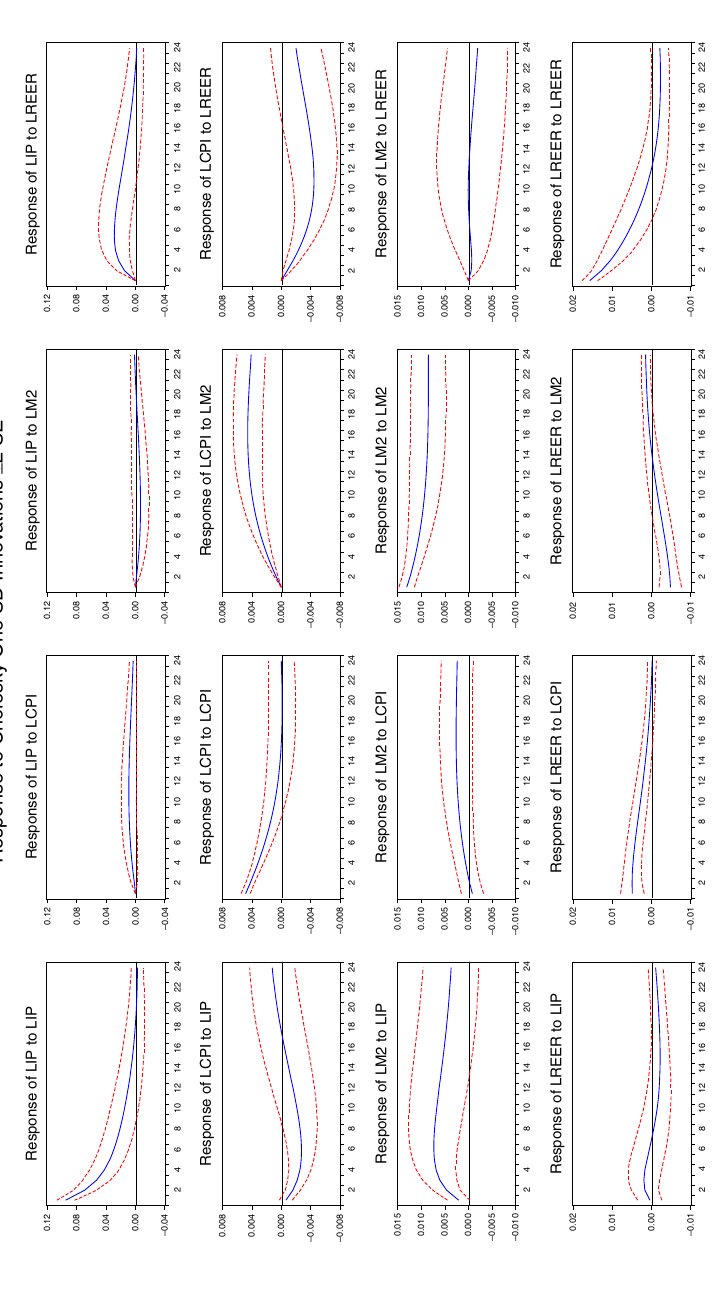
Figure A1. Impulse responses of Model